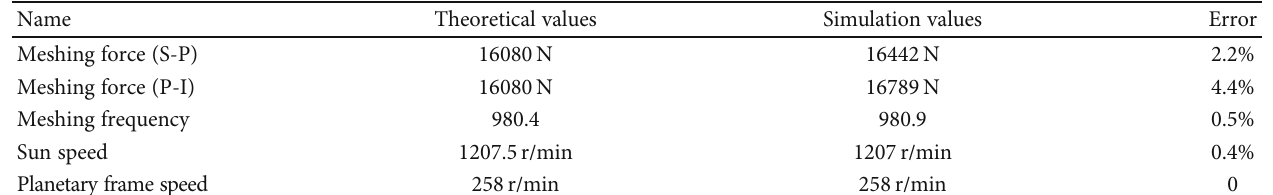
Table 2: A comparison between the simulation results and the theoretical calculation results.